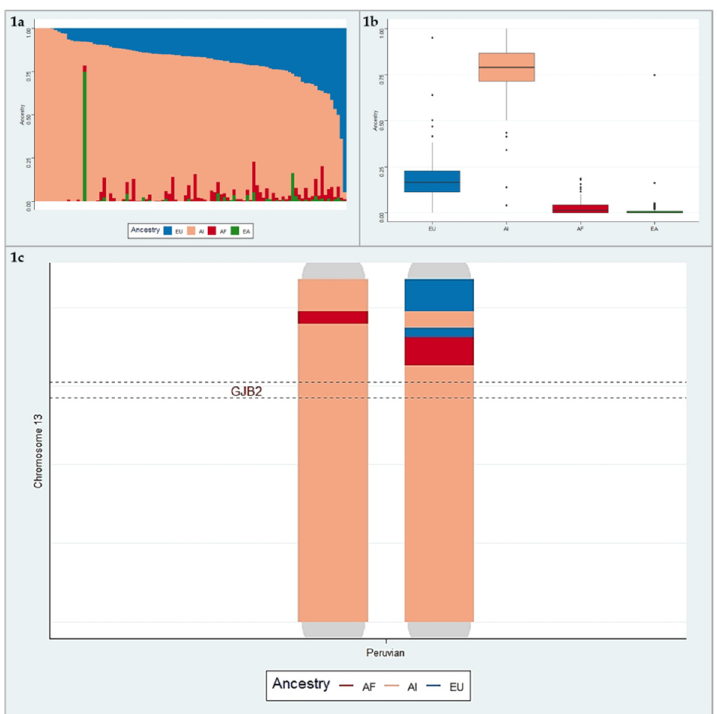
Figure 1. a. Bar-plot of four-way admixed Peruvian individuals estimated using ADMIXTURE software at K = 4. b. The box-plot of the average ancestries in Peruvian individuals. c. Illustration of local ancestry on chromosome 13. This figure represents admixture blocks “local ancestry”, with each ancestry coded by a different color (red: African (AF), blue: European (EU), pink: American Indian (AI)), from a Peruvian individual.